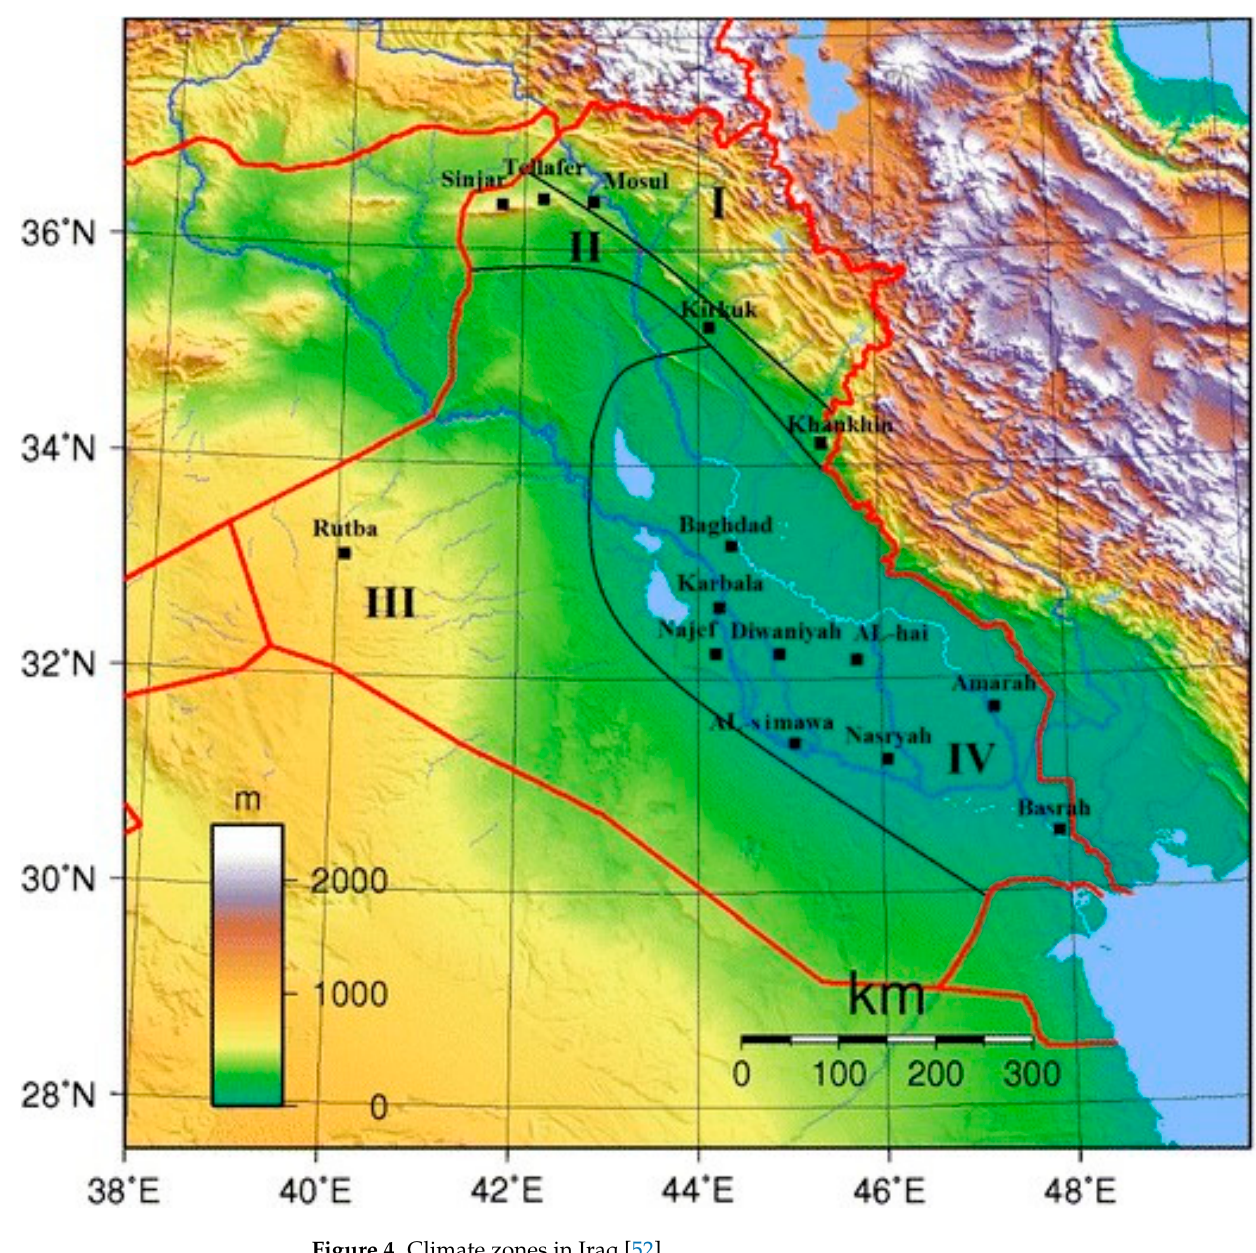
Figure 4. Climate zones in Iraq [52].